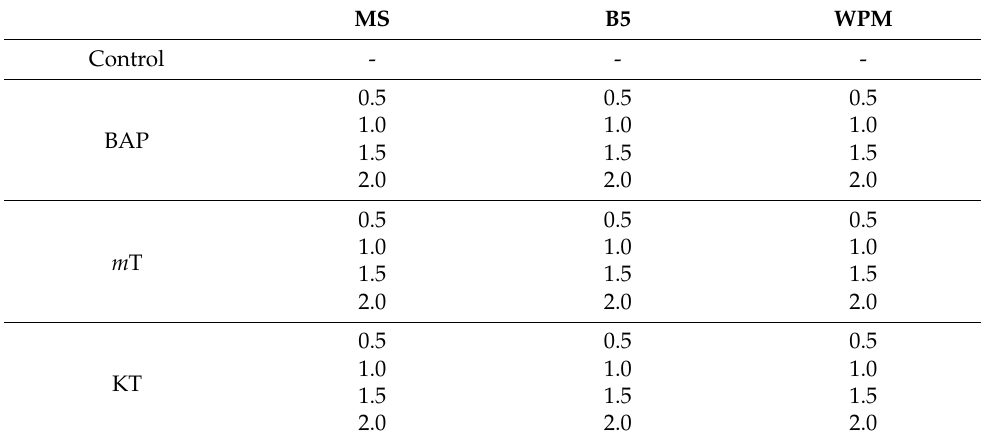
Table 1. Variants of experimental media for stimulating the animation of shoots of research objects in vitro . MS B5 WPM Control -